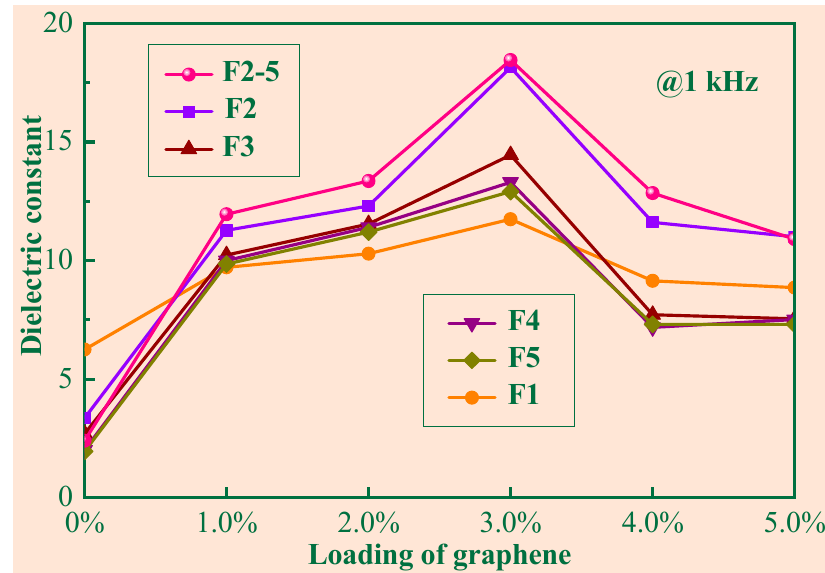
Figure 5. The dielectric constant (1000 Hz) of the composites.